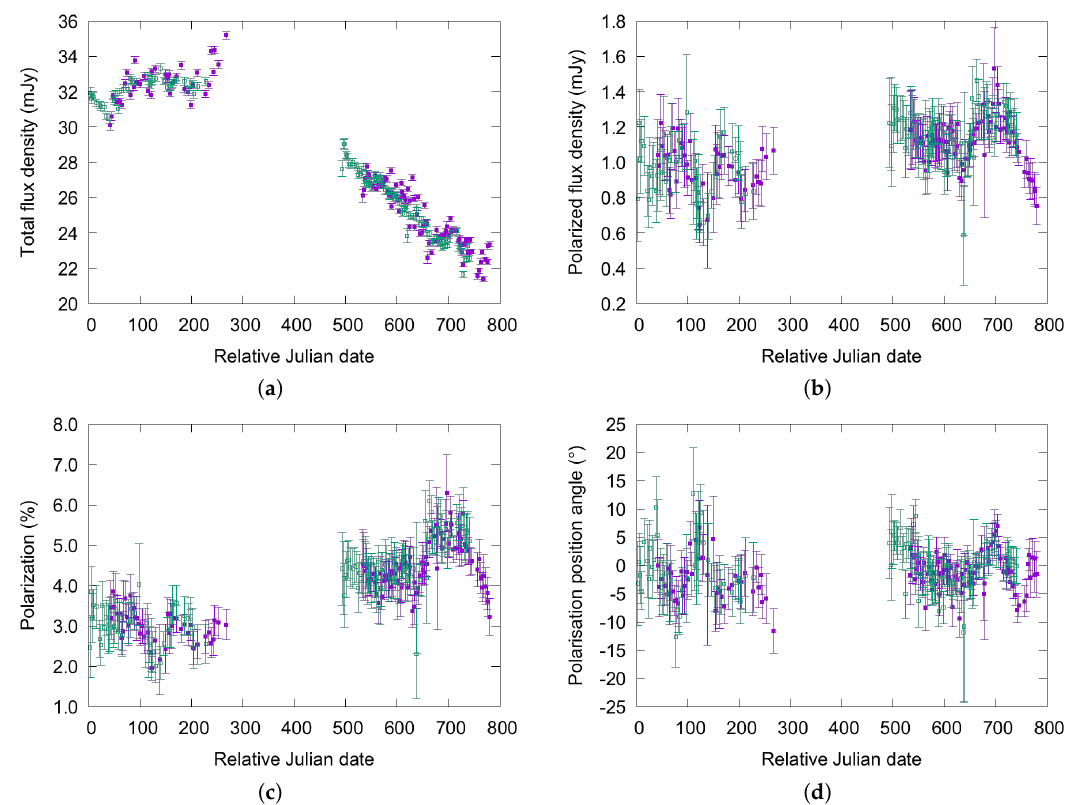
Figure 2. Light curves of images A (purple) and B (green) of B1600+434. ( a ) Total flux density. ( b ) Polarized flux density. ( c ) Percentage polarization. ( d ) Polarization position angle. Image A has been moved forward by 40 days [9] to compensate for the time